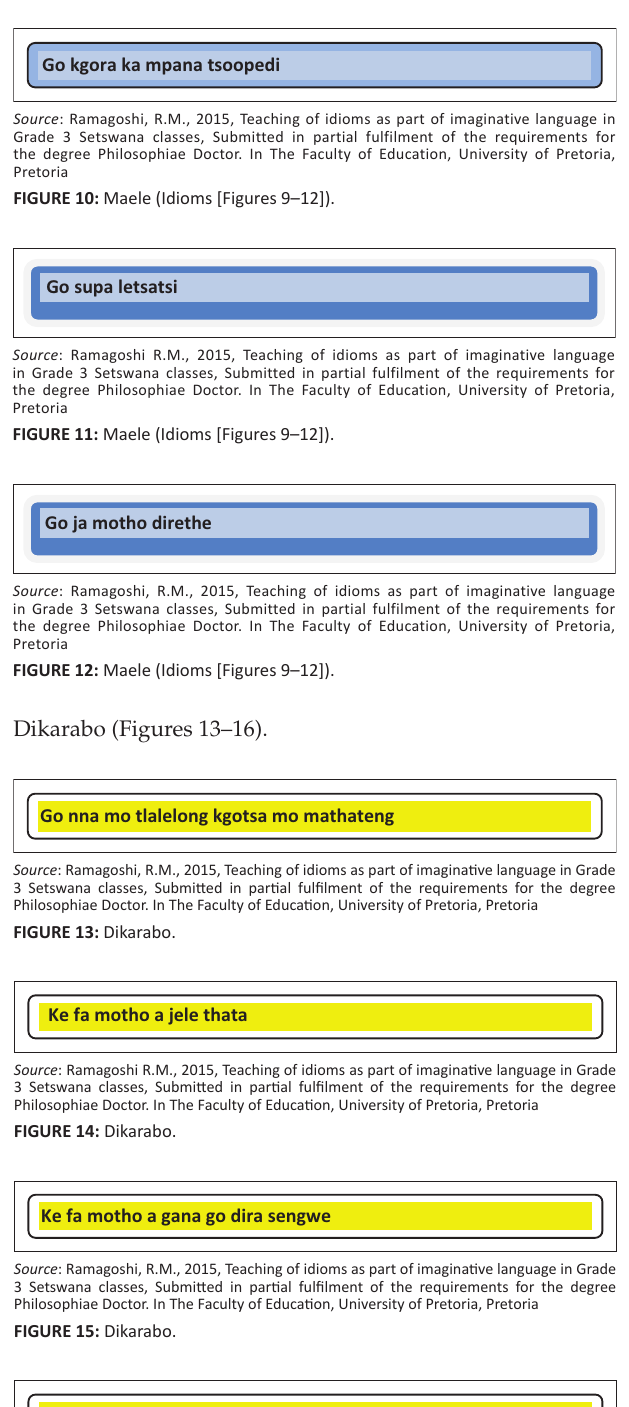
FIGURE 15: Dikarabo.